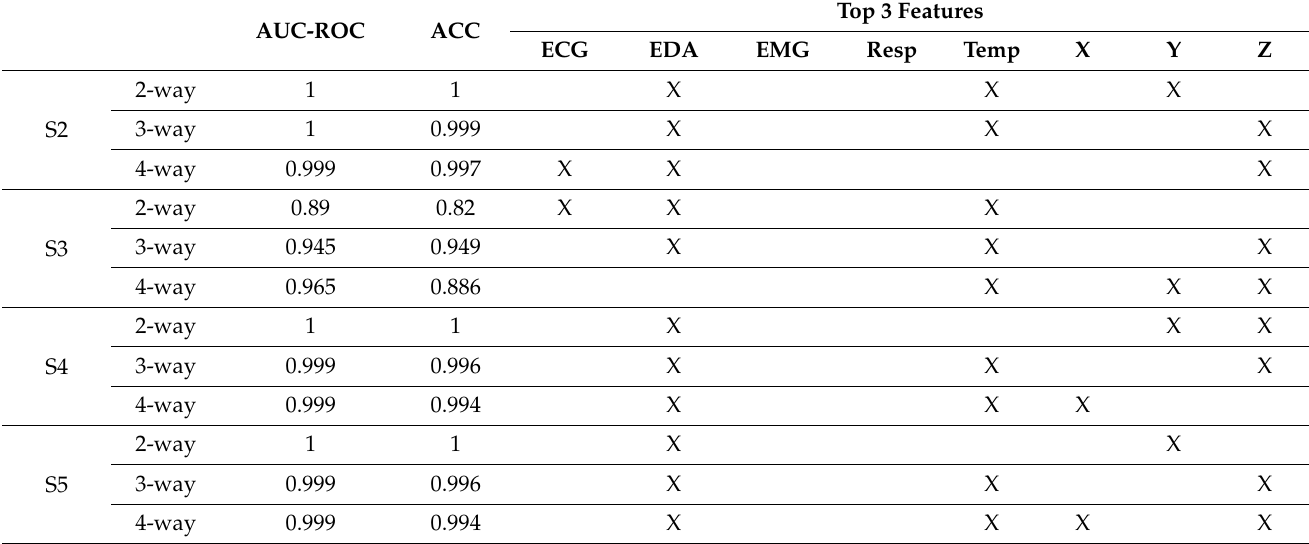
Table 2. Classification accuracy using logistic regression with top three